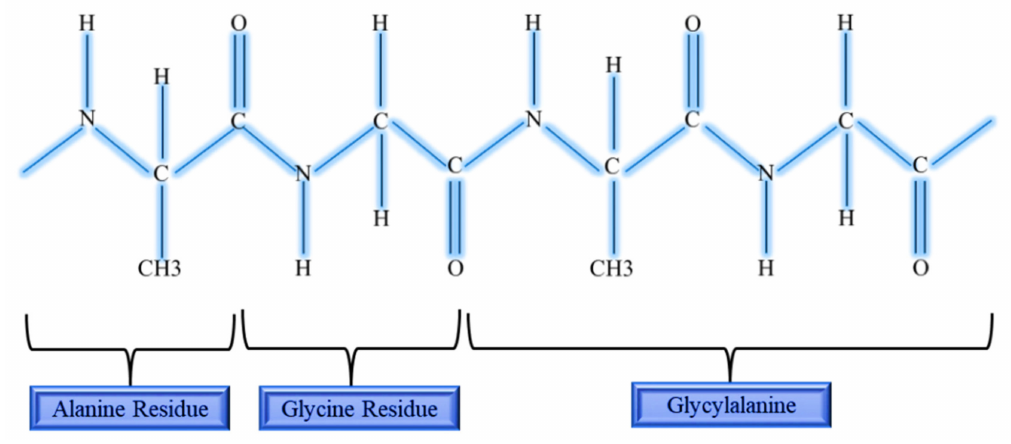
Figure 2. Chemical structure of silk